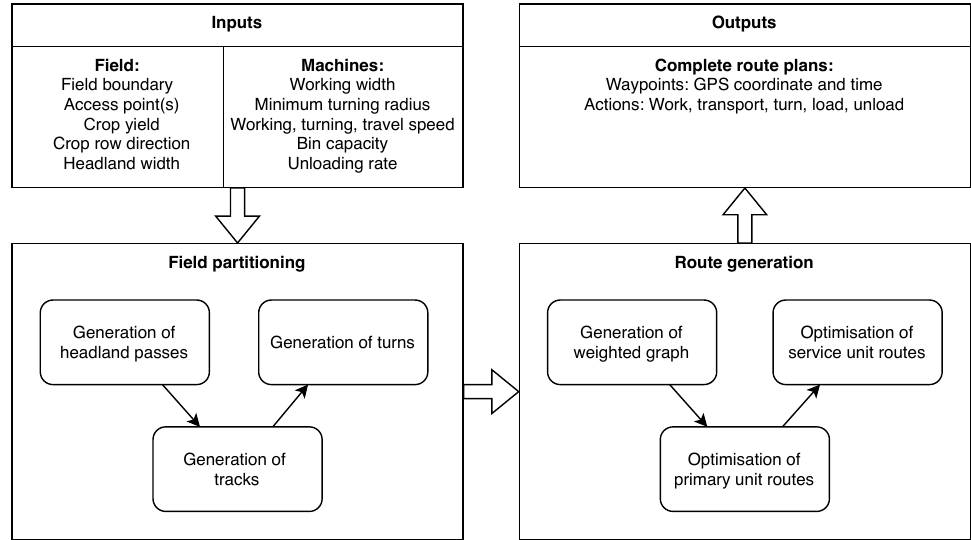
Figure 2. Flow diagram of the coverage path planning method showing the steps from the input of parameters and constraints to arable field partitioning, to a graph representation of the tracks, to a meta-heuristic optimisation, and to the final output as a complete simulation of optimised route plans for the PUs and